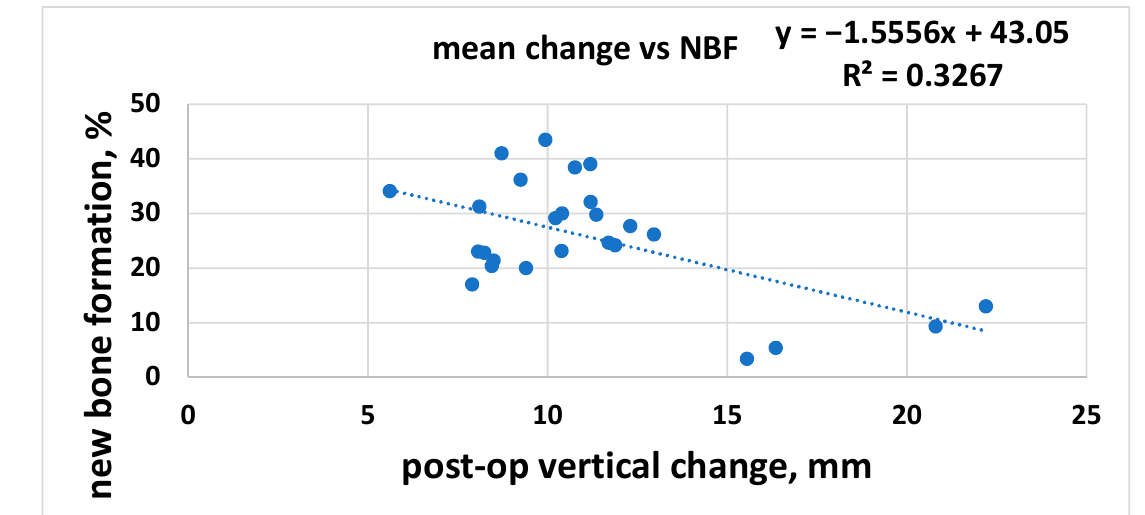
Figure 5. Post-operative vertical change and NBF .